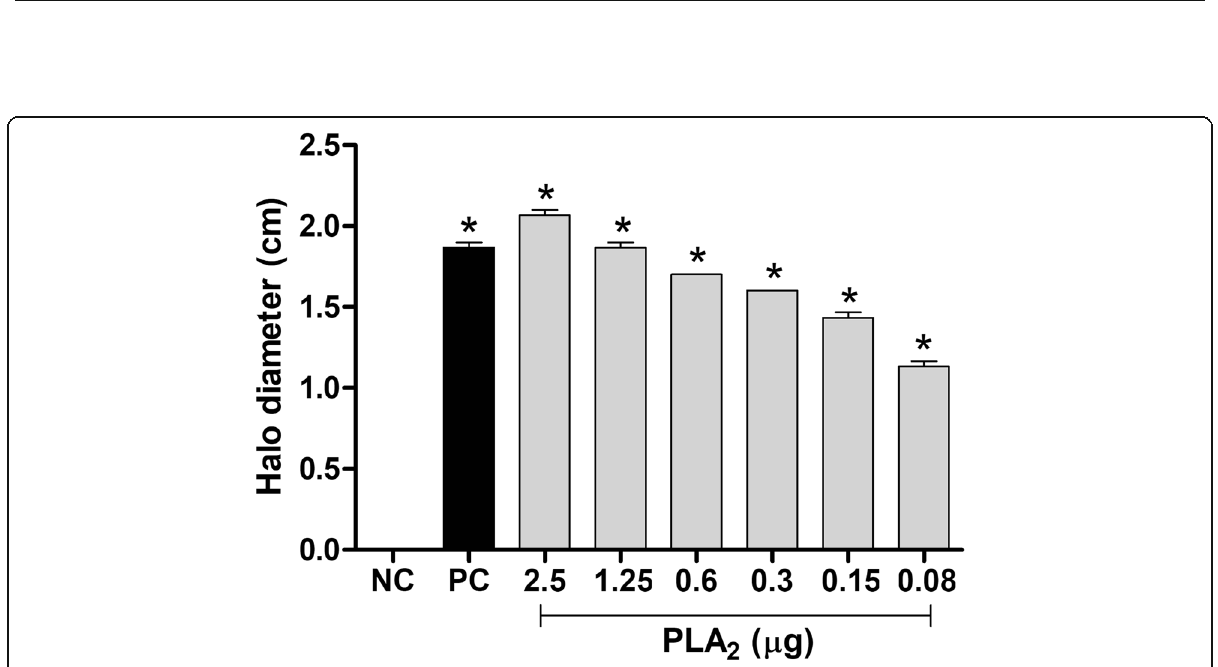
Fig. 5 Phospholipase activity of BJ-PLA 2 -I. The assay was evaluated on egg yolk-agar plates incubated overnight at 37 °C with PBS (NC = negative control), B. jararaca venom (15 μ g) (PC = positive control) or BJ-PLA 2 -I (0.08 – 2.5 μ g). The phospholipase activity is relative to the size (in cm) of translucent halos formed by each sample. Results were expressed as means ± SD ( n = 2) of two independent experiments. * p < 0.05 compared to the negative control